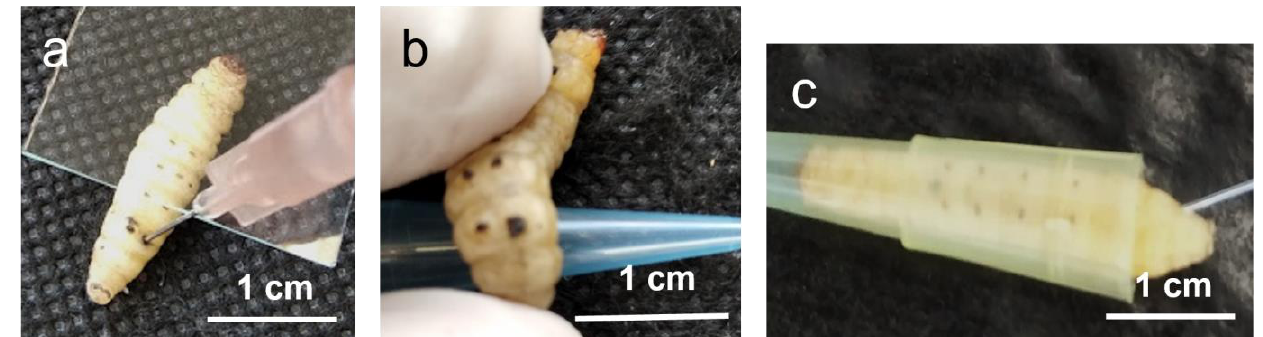
Figure 2. Restraining devices for handling Galleria mellonella larva. ( a ) using a microscope blade to immobilize the larva; ( b ) using a blue pipette tip to turn the left proleg to make it more visible; (c) using a yellow tip to immobilize the larva (original).